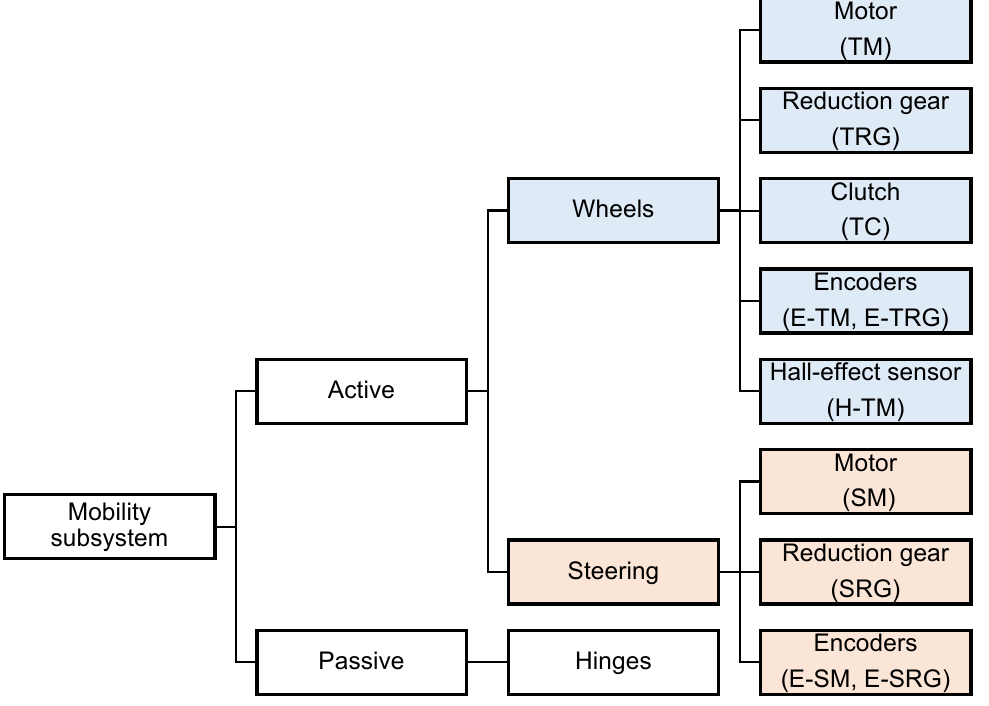
Figure 4. Mobility system hierarchical